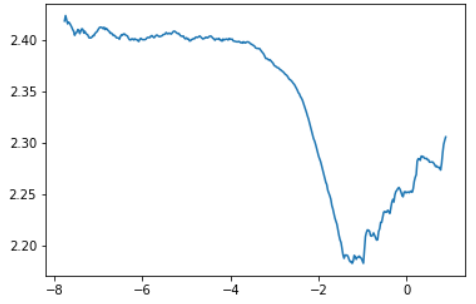
Figure 2. Learning rate range test. The x-axis is learning rate (log scale), the y-axis is training